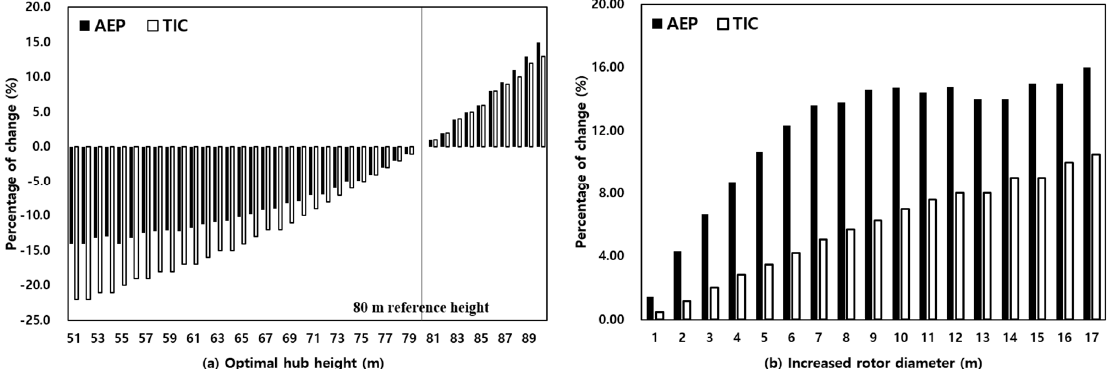
Figure 10. Percentage change for AEP and total investment cost (TIC) with respect to ( a ) OHH and ( b ) increment of RD.